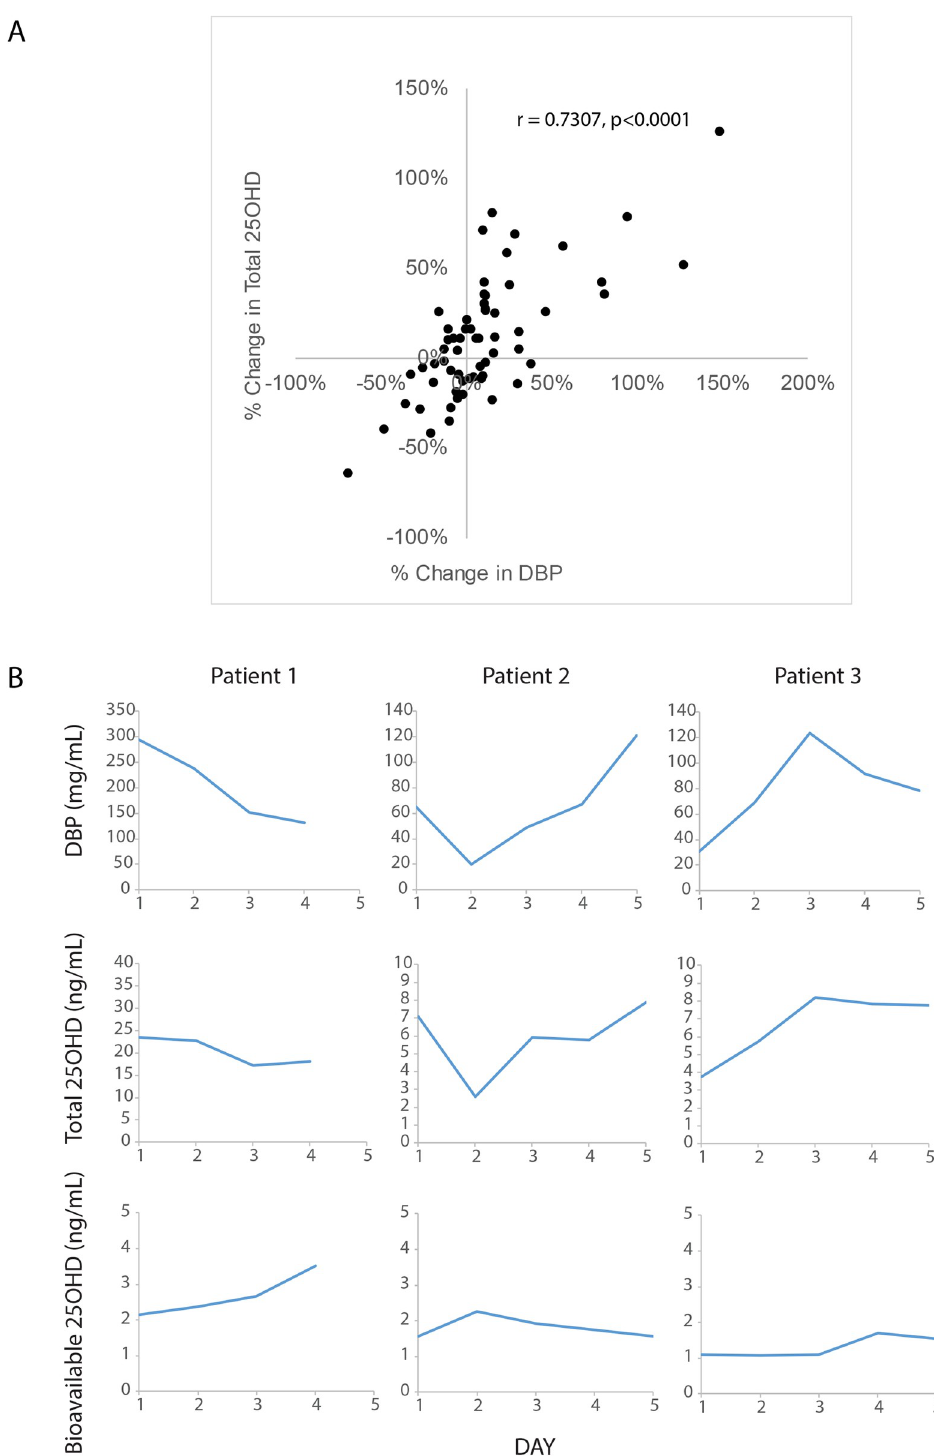
Fig 5. Relationship between changes in concentrations of DBP and measured bioavailable 25OHD over time in acutely ill patients. (A) Correlation between % changes over time in total 25OHD and % changes in DBP concentrations in ICU patients. (B) Time course graphs comparing changes in concentrations of DBP, Total 25OHD, and Bioavailable 25OHD during the weeklong study period in three representative patients.